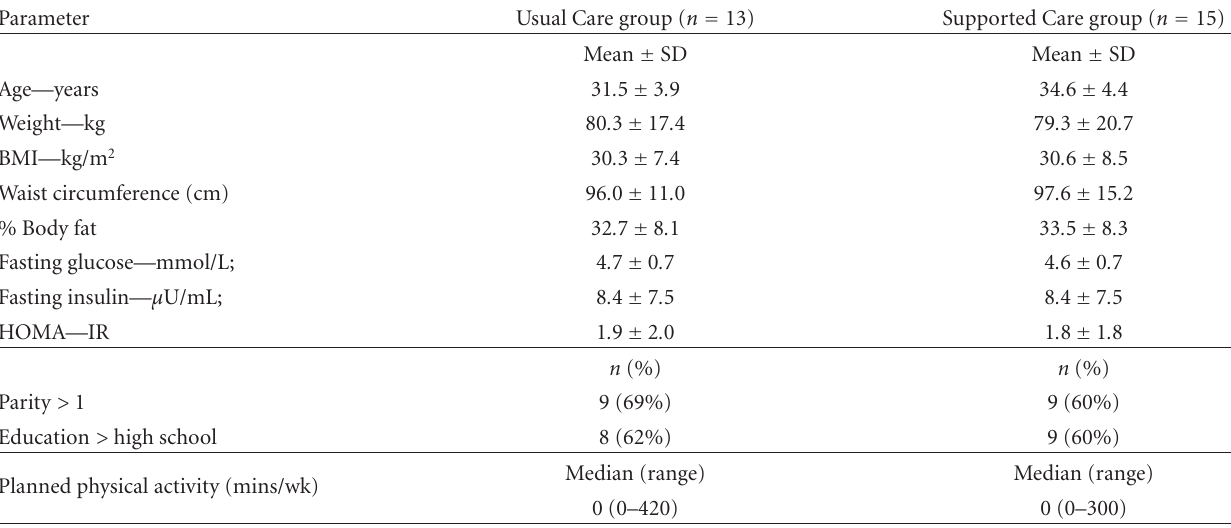
Table 1: Prestudy characteristics of women, at the baseline visit (six weeks postpartum), divided by treatment group.